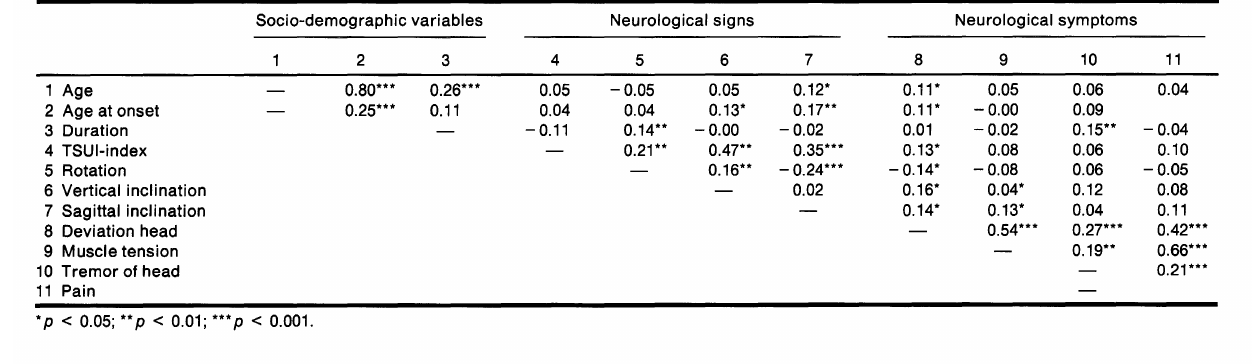
TABLE I. Correlations between socio-demographic variables, signs (neurological assessment) and symptoms (self reported). The correlations between signs and symptoms are